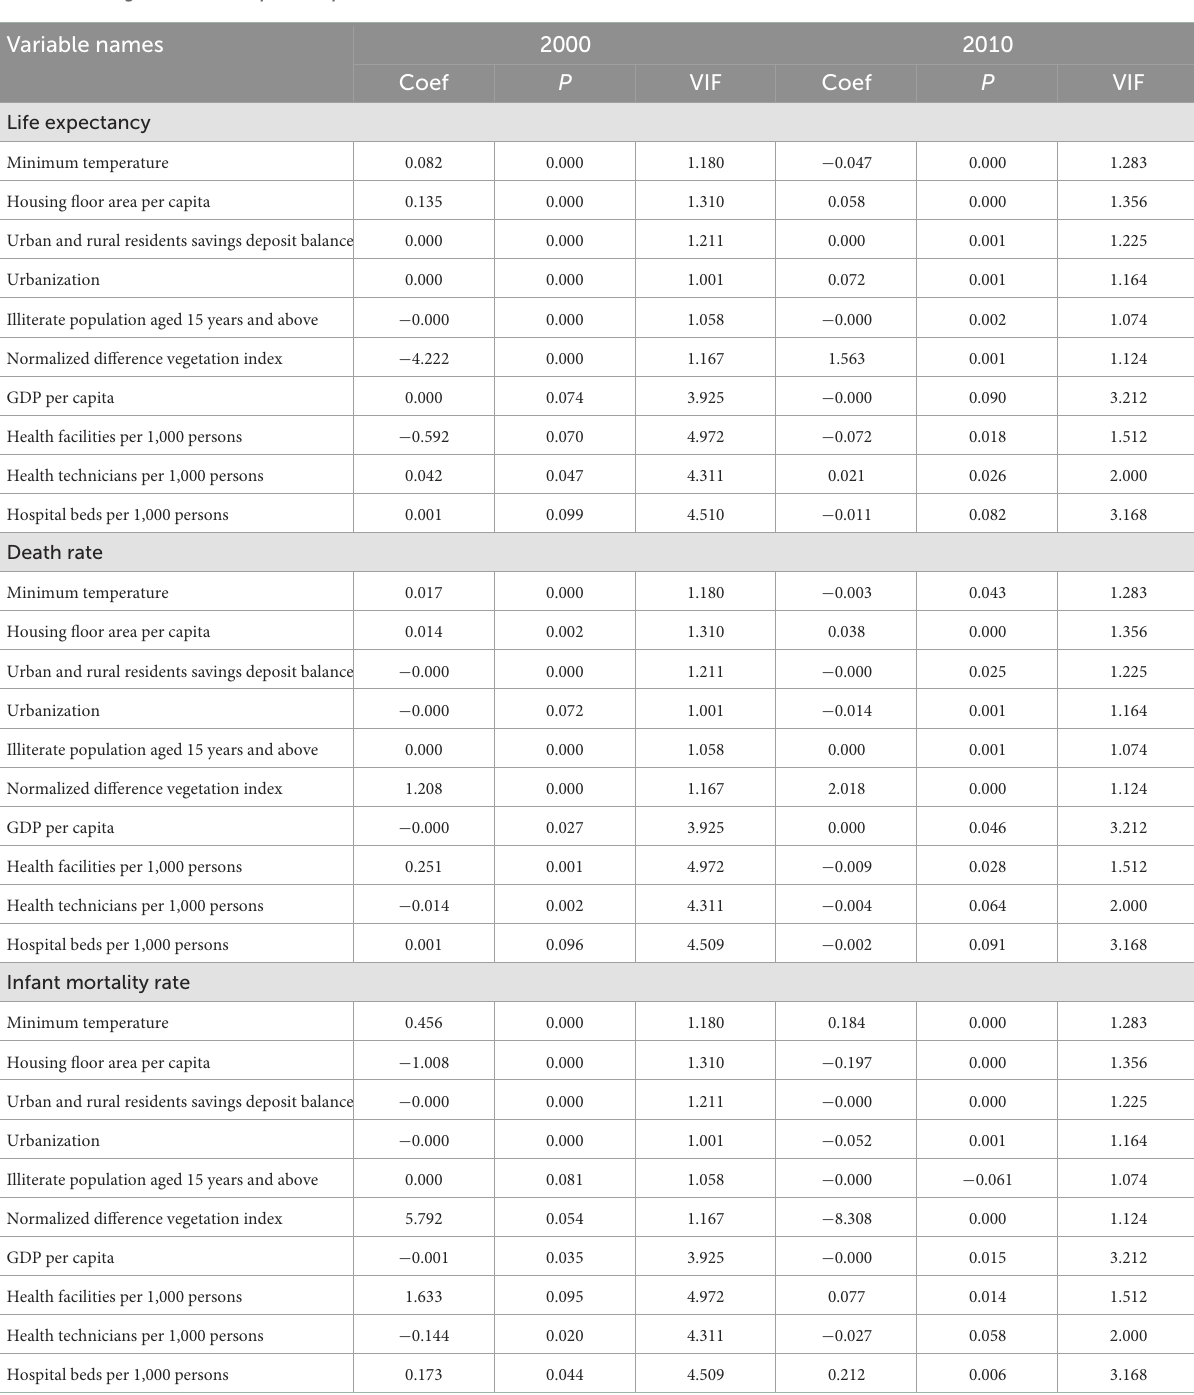
TABLE 3 OLS regression results; p -value ( p <